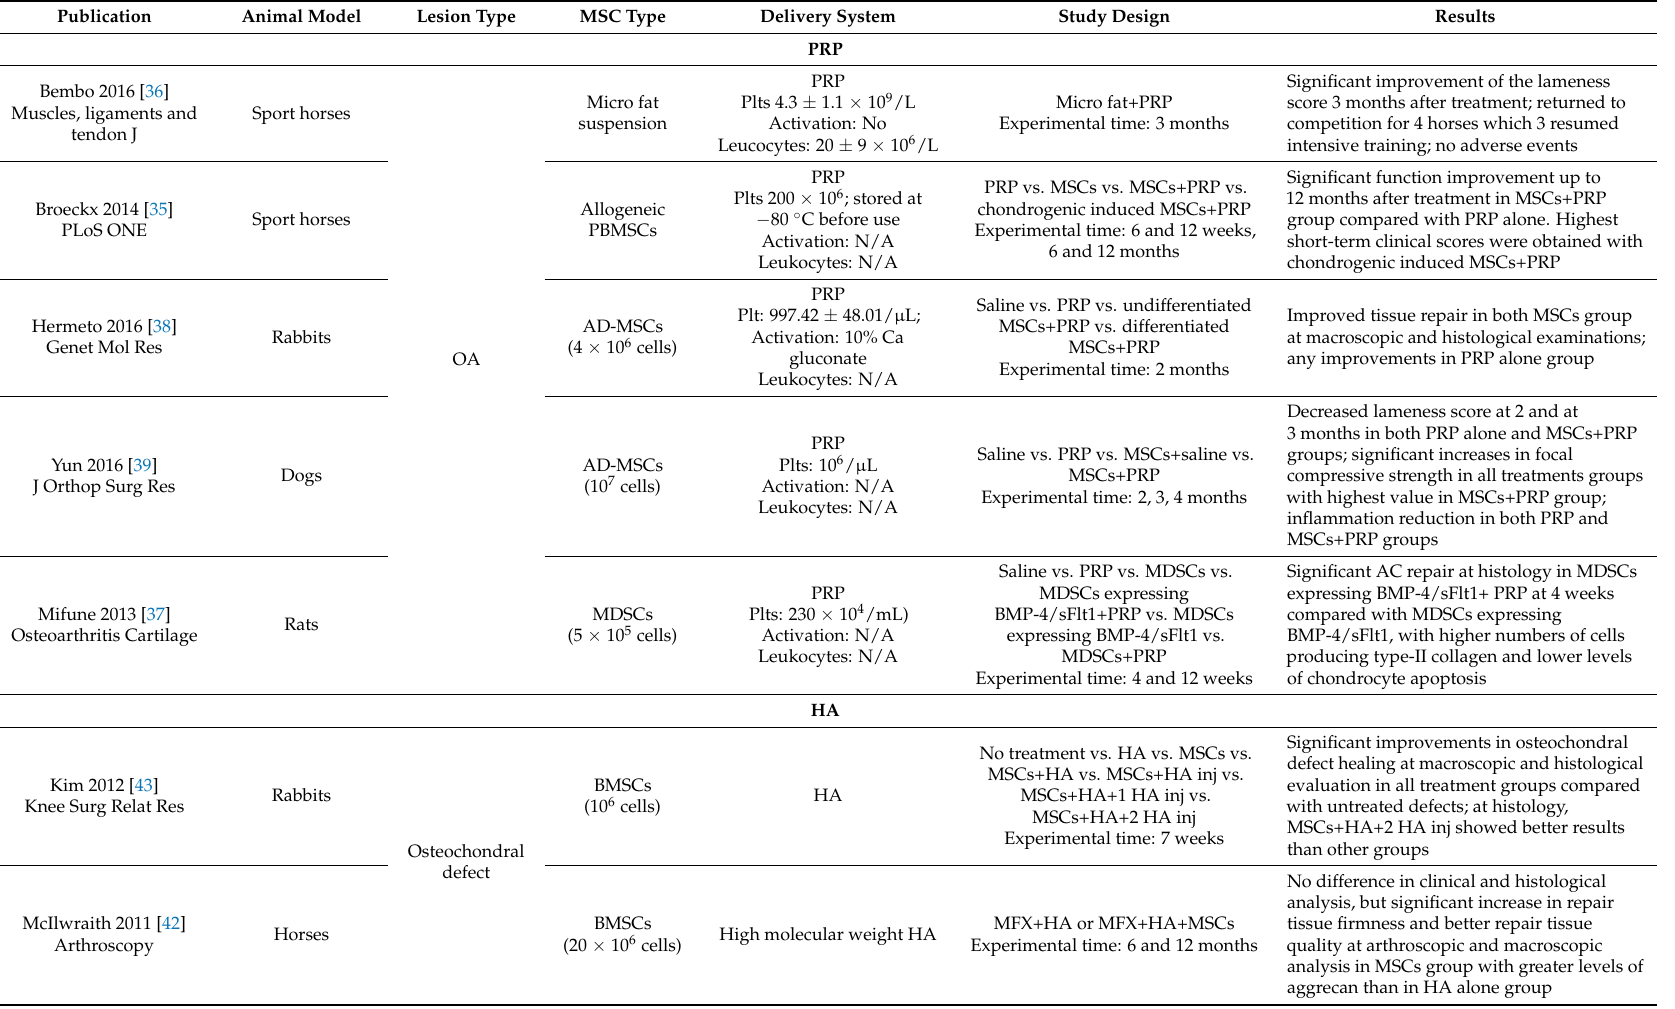
Table 1. Details of preclinical papers identified in the systematic